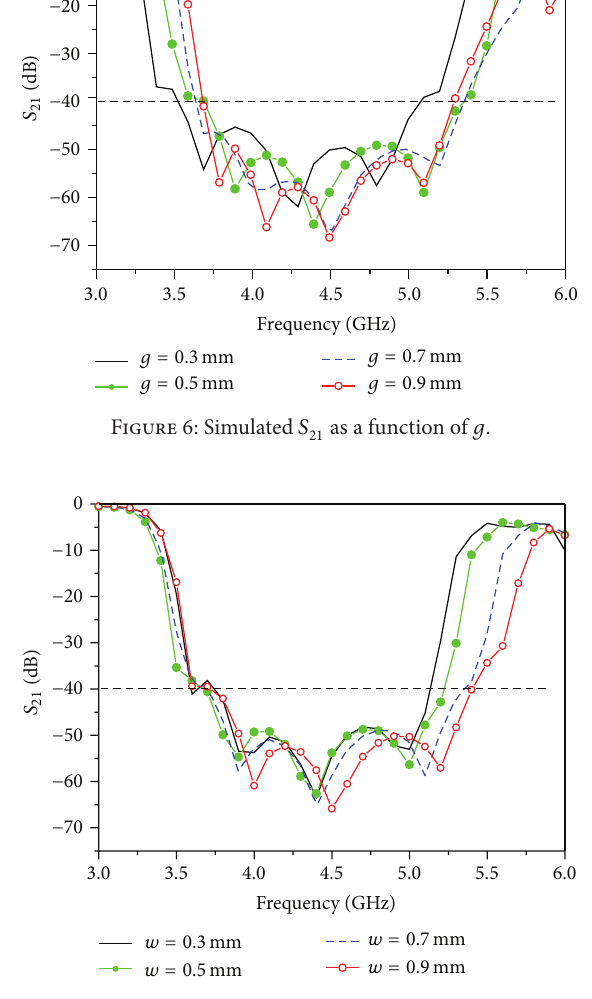
Figure 7: Simulated 𝑆 21 as a function of 𝑤 .